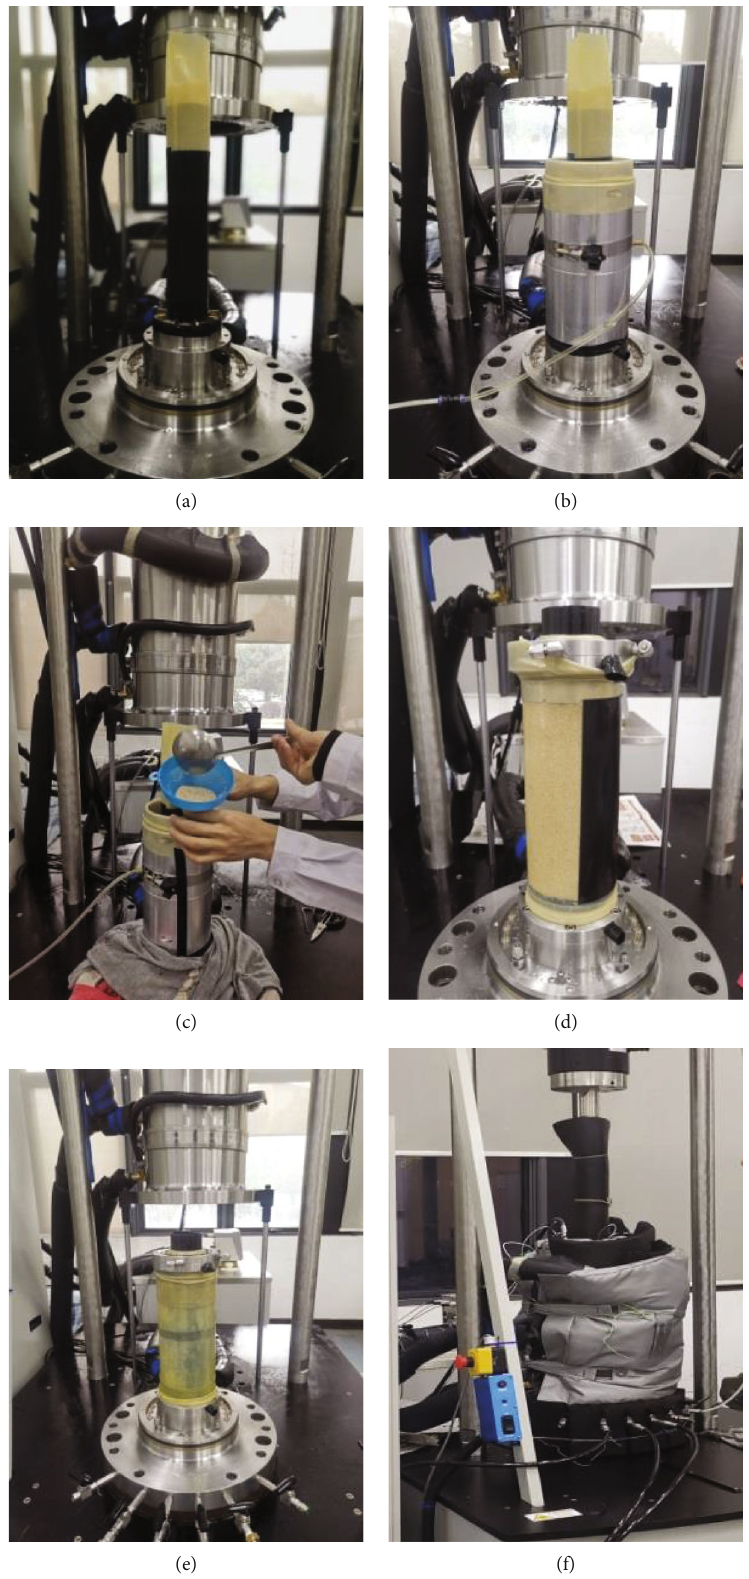
Figure 2: Preparation procedures of hollow cylindrical specimen of the